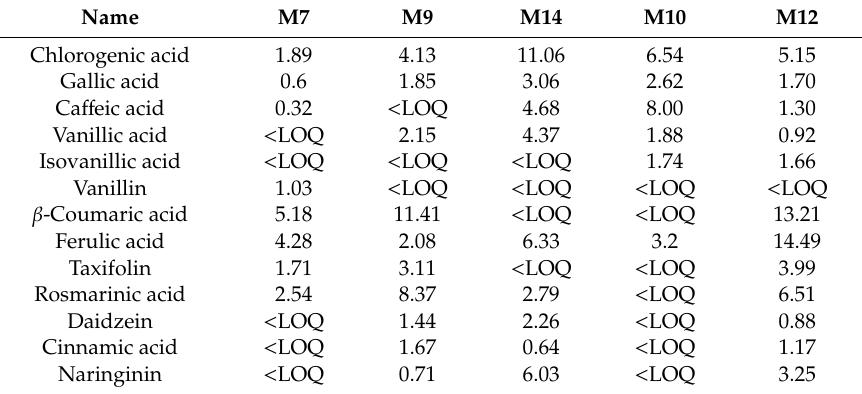
Table 4. Phenolic compositions (%) in the eight seed oil samples.